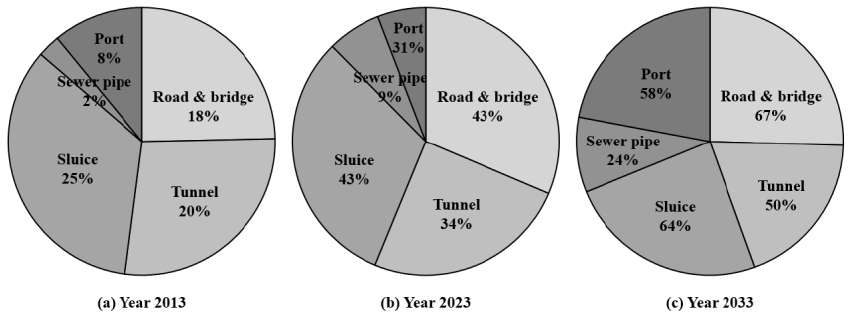
Figure 1. South Korean infrastructure sectors, with percentage of each sector constructed over 50 years ago [1].